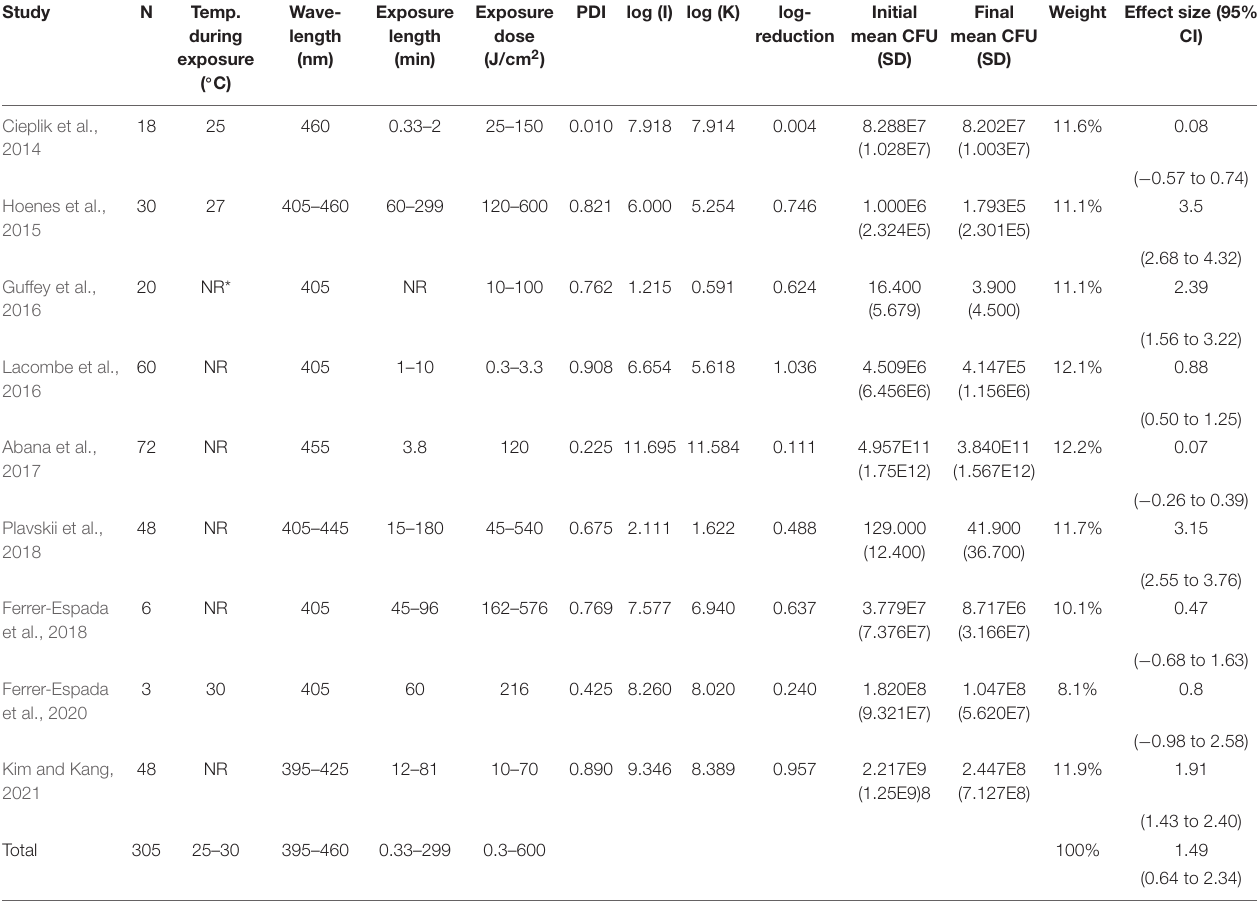
TABLE 2 | Characteristics of all included studies.